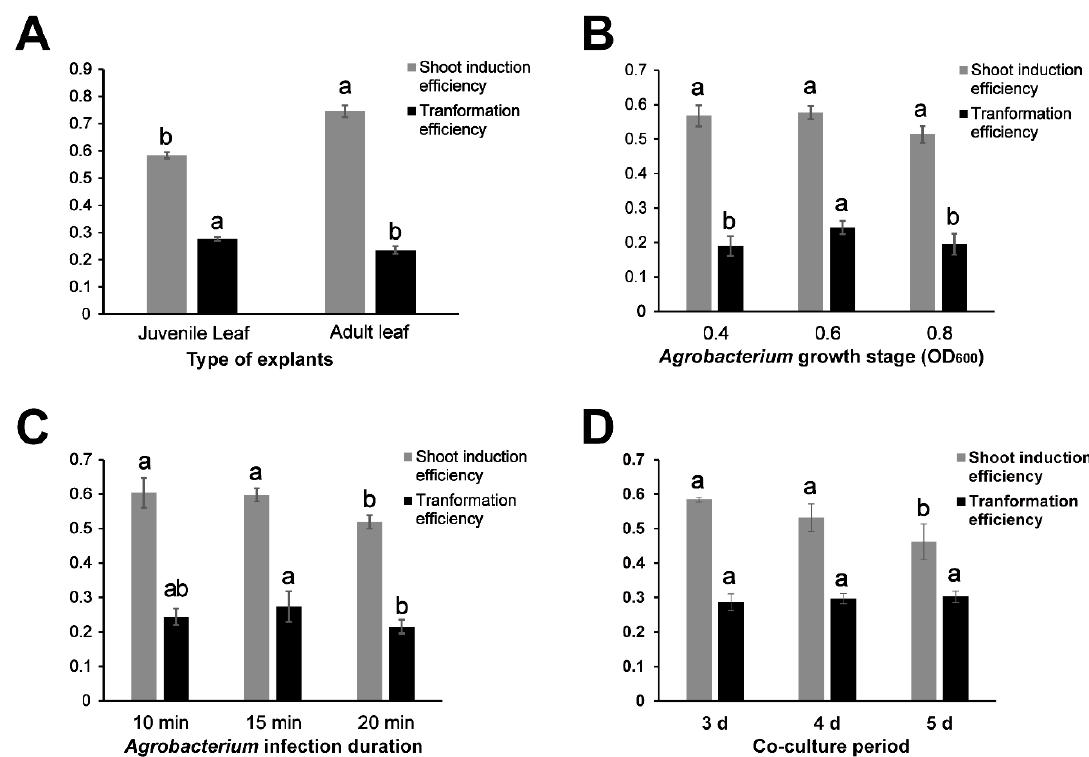
Figure 1. Factors that affect the shoot induction efficiency and transformation efficiency of P. alba × P. glandulosa . ( A ) Ages of leaves. ( B ) Growth stages of Agrobacterium bacteria. ( C ) Agrobacterium infection duration. ( D ) Co-culture period. a and b showed the statistical significance of differences that determined using the Student’s t -test ( p < 0.05).